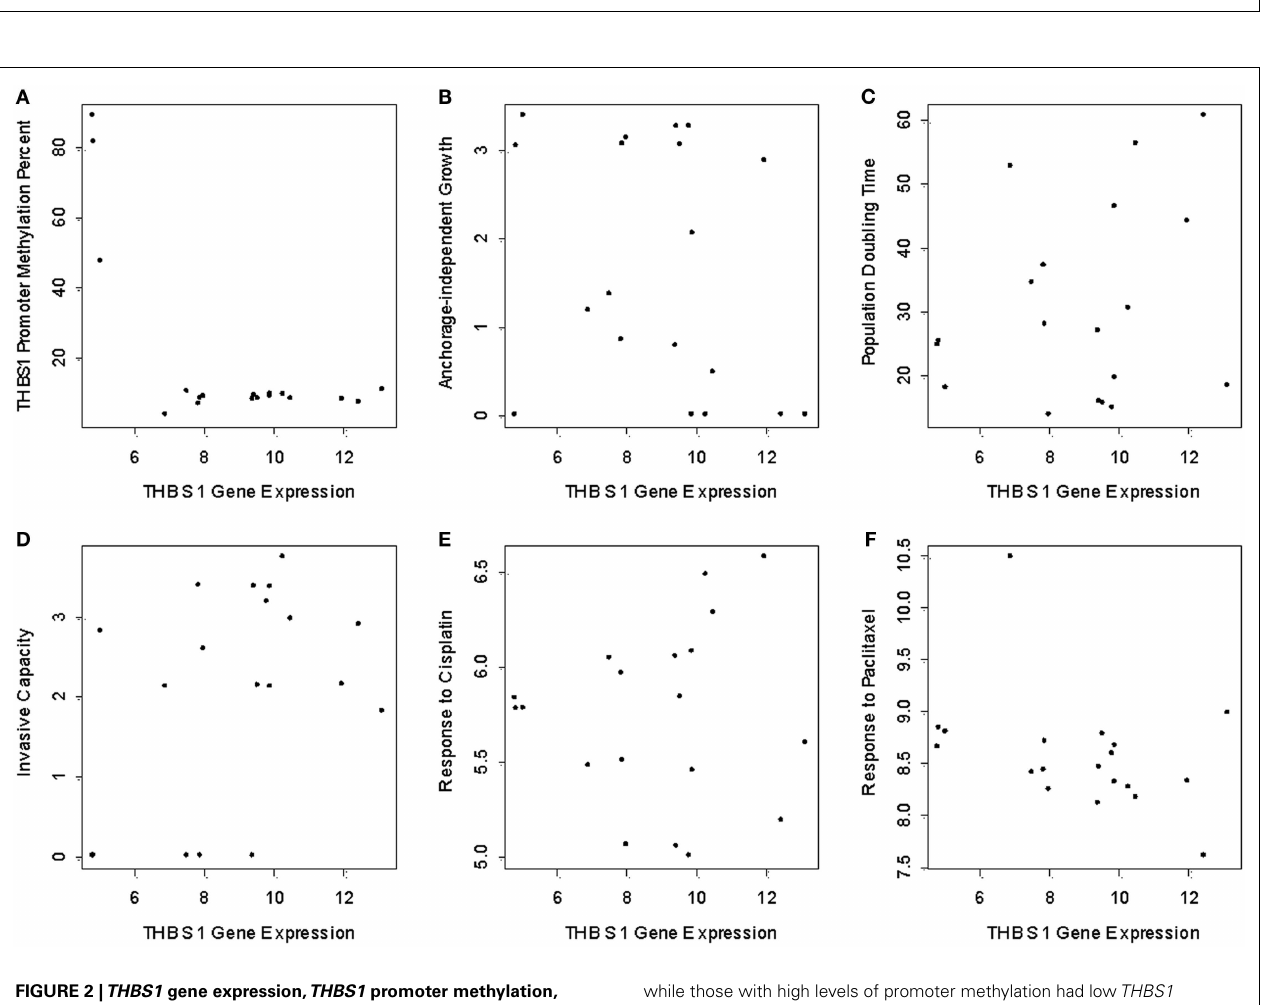
while those with high levels of promoter methylation had low THBS1 gene expression.There was no association between THBS1 gene expression with anchorage-independent growth; (B) population doubling time (C) invasive capacity; (D) or cisplatin; (E) and paclitaxel; (F) IC50